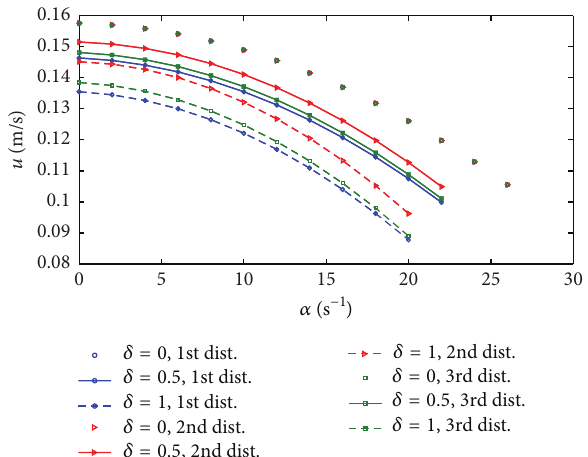
Figure 12: Influence of heat loss parameter on spray flame propaga- tion velocity for different initial droplet loads—polydisperse